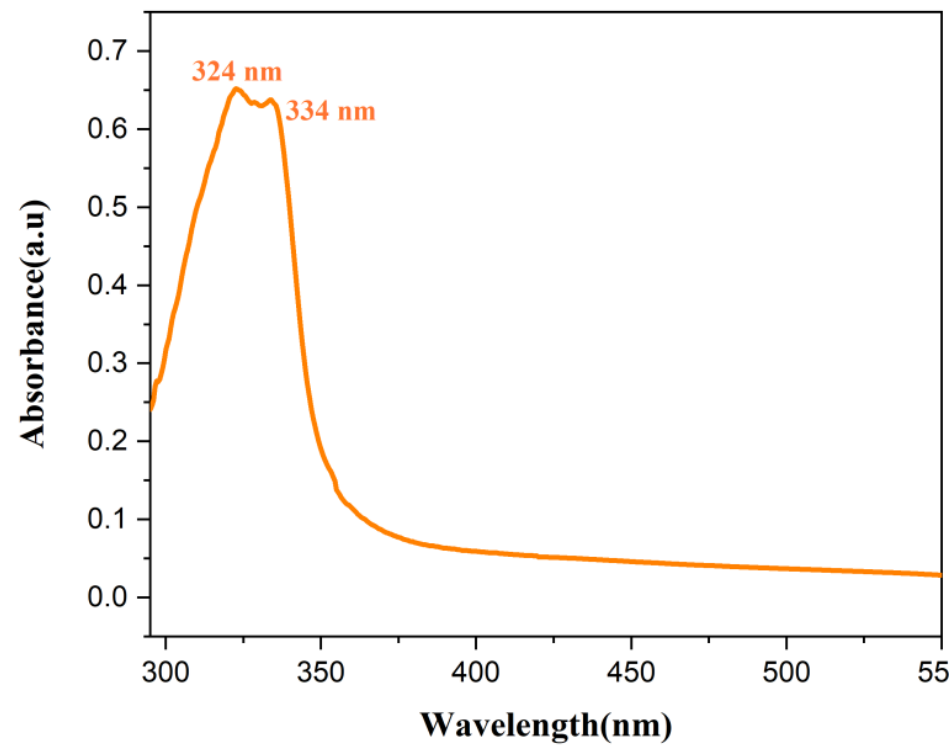
Figure 4. UV-vis spectrum of biogenic CuO NPs.